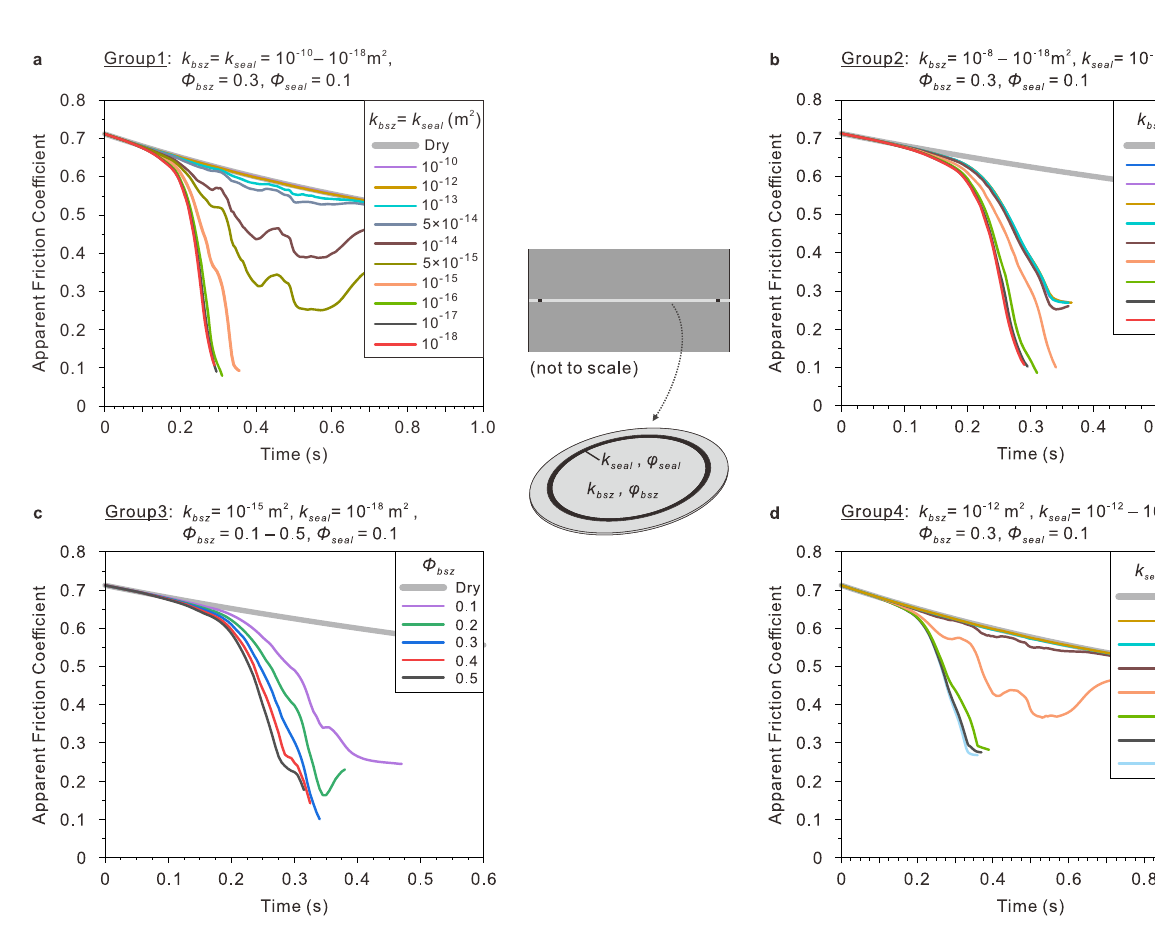
Fig. 4 | Numerical modeling of sealing-enhanced thermal pressurization (TP). The evolution of friction coef fi cient is predicted from the TP modeling that con- siders the wear-induced sealing effect (sealing zone exists in the bulk shear zone; see “ Methods ” ). a – d Modeling results for various combinations of permeability ( k )